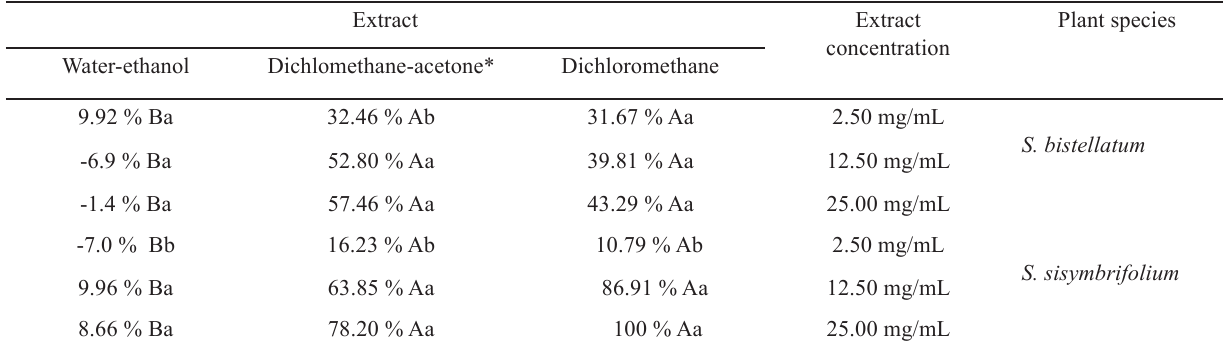
* Enriched fraction of sugar esters Mean of five replicates (n=30 termites per replicate). Values followed by the same letter,in lines(capital letters) for each plant extract and concentration in columns (lower case letters), are not different from each other (Tukey’s test,